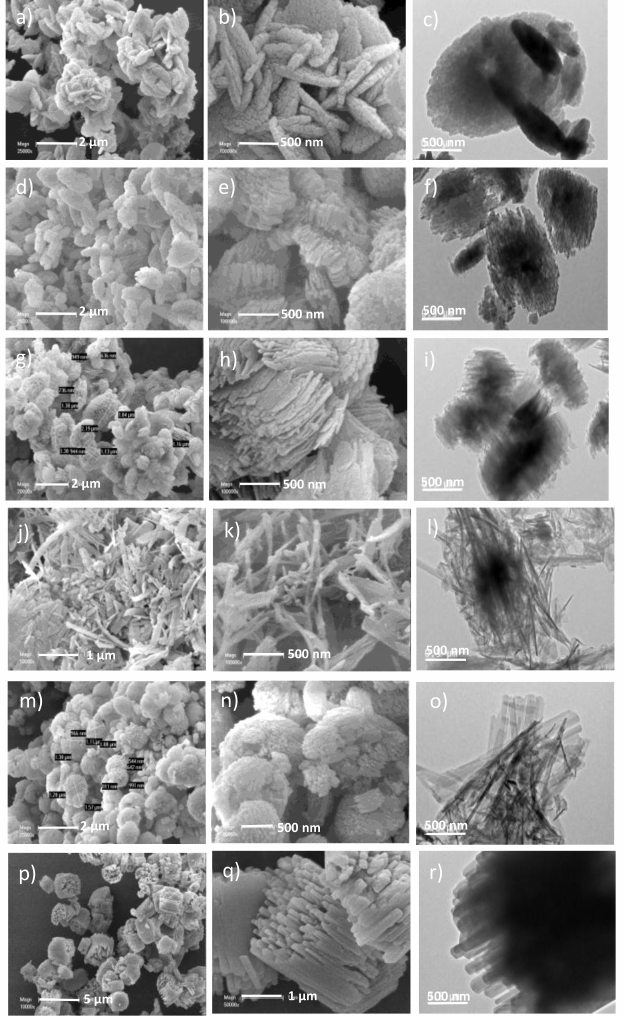
Figure 2. SEM and TEM images: 0.033 S 0 130/7 ( a , b , c ); 0.033 S 0.01 130/7 ( d , e , f ); 0.033 S 0.02 130/7 ( g , h , i ); 0.033 S 0.04 130/7 ( j , k , l ); 0.066 S 0.02 130/7 ( m , n , o ) and 0.066 S 0.02 180/1 ( p , q , r